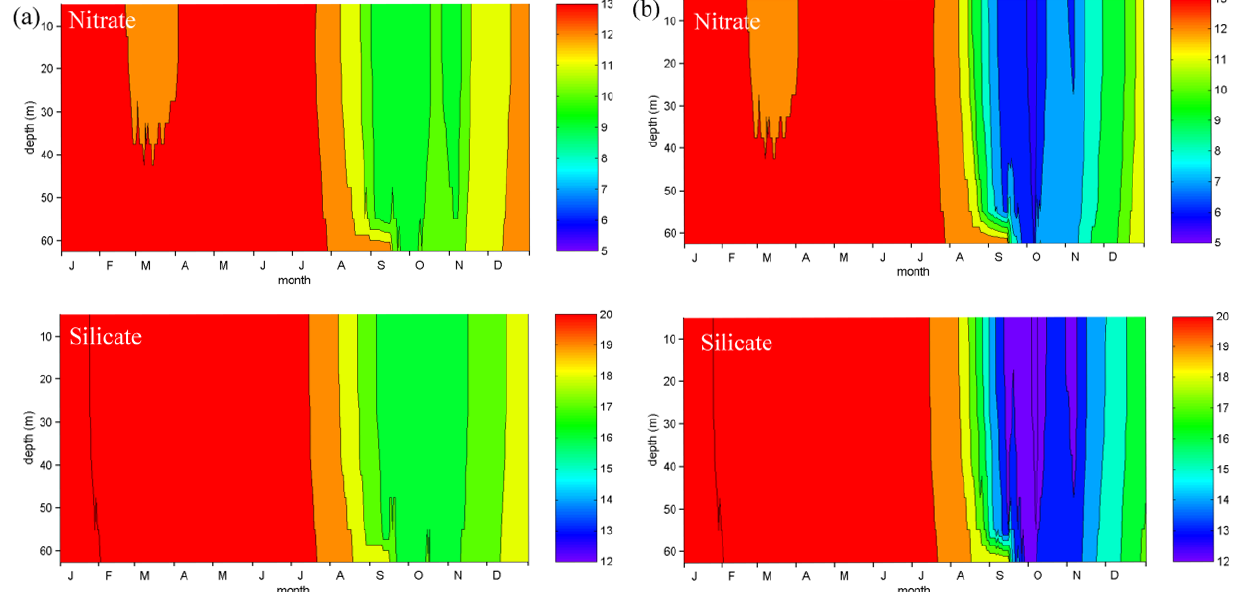
Fig. 9. Temporal evolution of the modelled vertical profile of nitrate [µmolNL − 1 ] and silicate [µmolSiL − 1 ] in the upper 63m of the surface ocean at Papa during 2008 (a) without and (b) with iron fertilisation in August 2008.